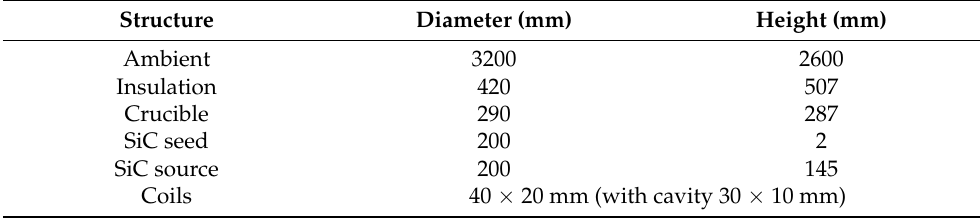
Figure 1. Thermal field structure and schemes. ( a ) Whole computational domain; ( b ) The physical field; ( c ) Thermal field details under different schemes. Table 1. Parameters of main structures.